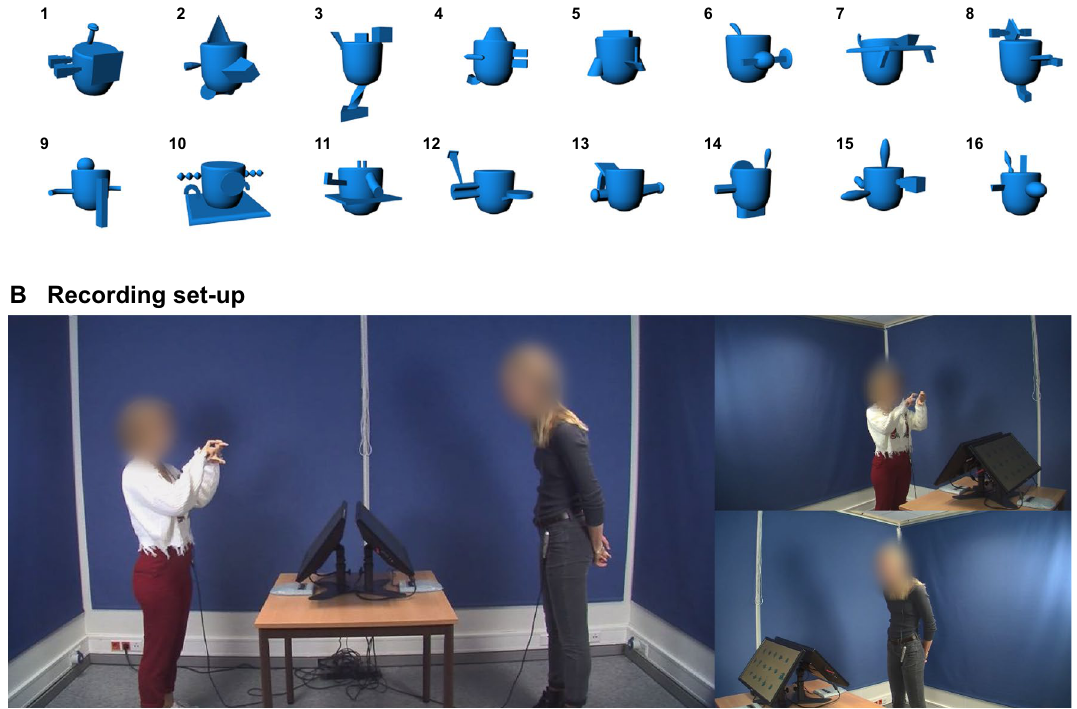
Figure 3. Panel ( A ) shows the “Fribbles” that were used as stimuli. Panel ( B ) shows the set-up by means of screenshots from the three